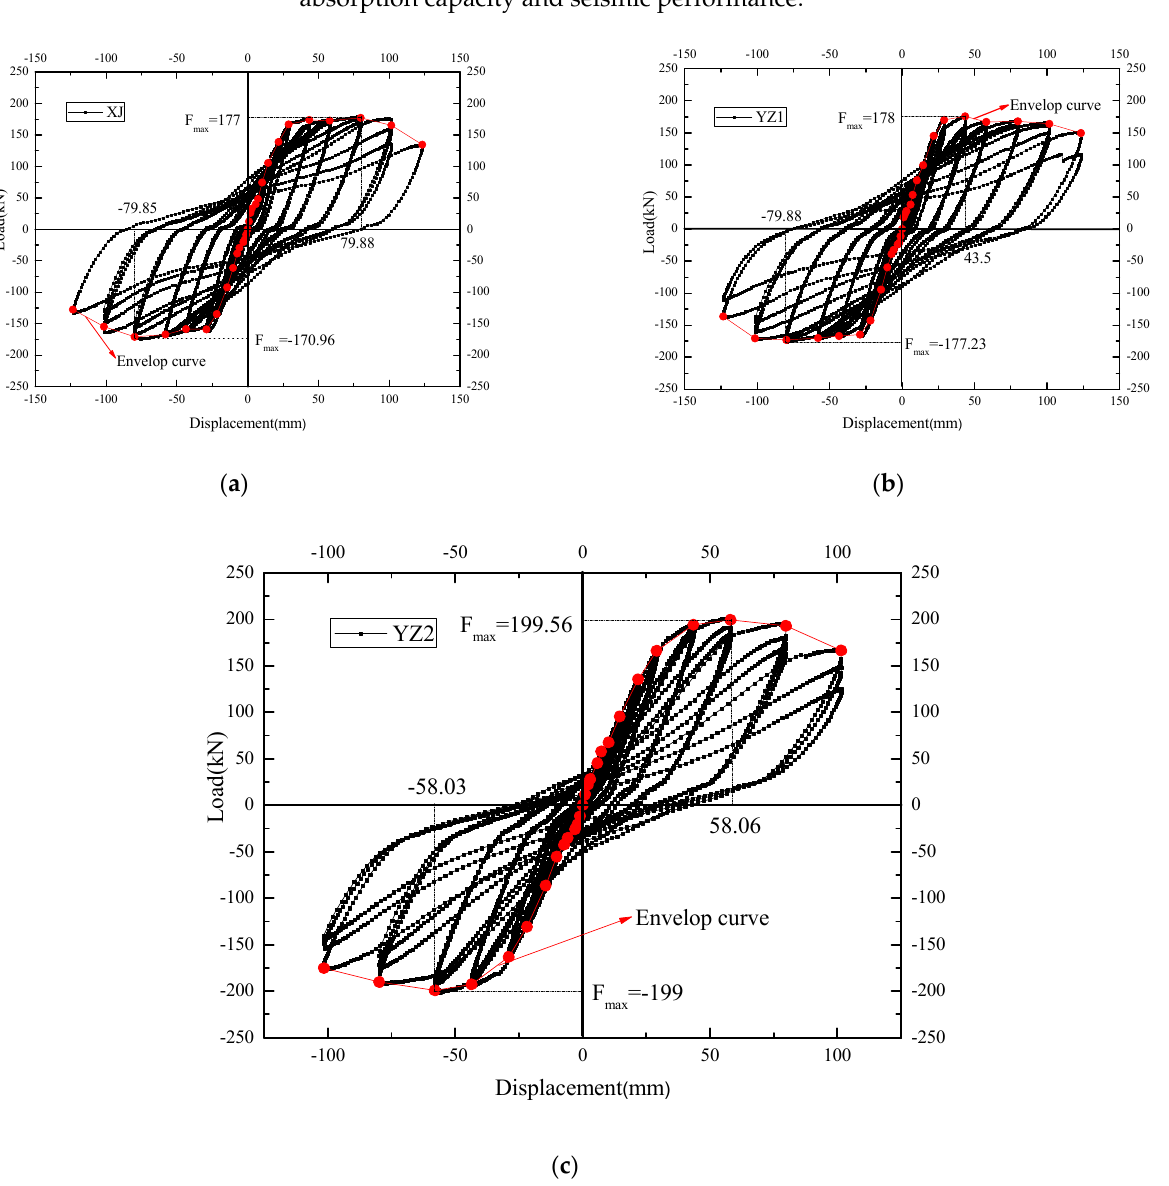
Figure 11. The hysteresis curve and skeleton curve of the joints. ( a ) XJ. ( b ) YZ1. ( c ) YZ2.